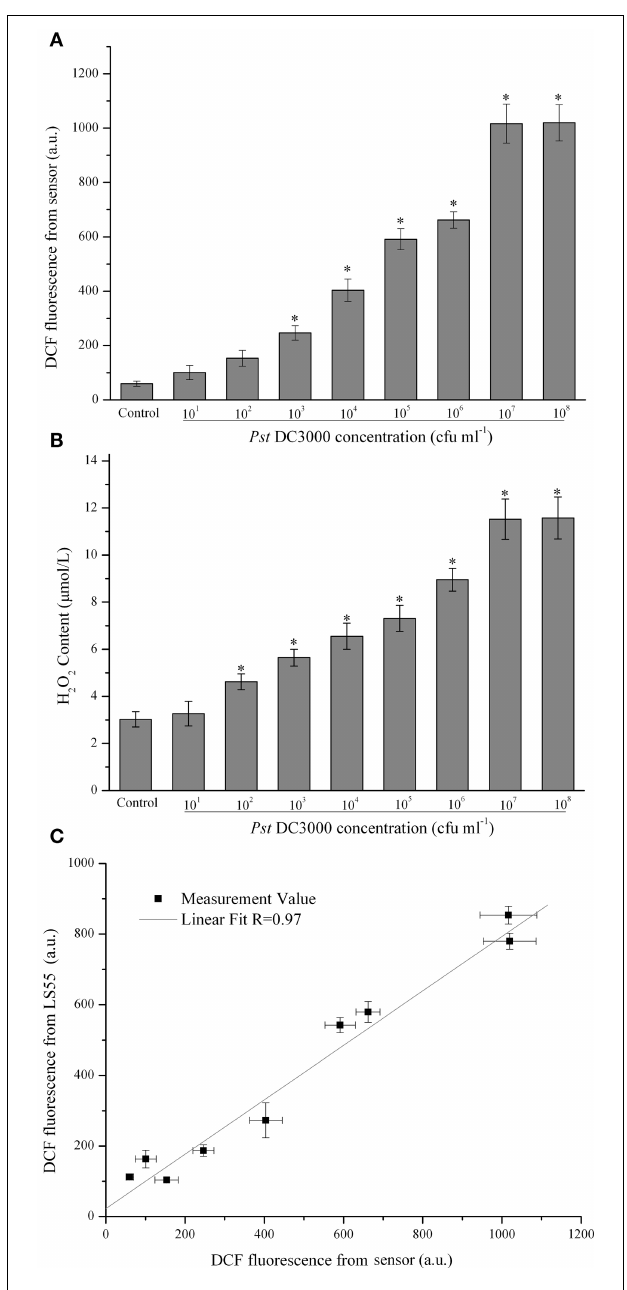
FIGURE 2 | Quantitative analysis of concentration-dependent changes in the dichlorofluorescein (DCF) fluorescence intensity of Arabidopsis thaliana (A. thaliana) leaves infected with Pseudomonas syringae pv .tomato DC3000( Pst DC3000). TheDCFfluorescencewasdeterminedby the optical device with difference concentration of Pst DC3000 infection (A) . The mean ± SD of the fluorescence intensity is shown for five independent A. thaliana leaves inoculated with Pst DC3000 or 10mM MgCl 2 (Control). There were a significant effect of DCF fluorescence obtained from optical device on the infected concentration with Pst DC3000 ( F 1 , 8 = 228 . 179, p < 0 . 01). The H 2 O 2 content was determined according to the standard procedureofahydrogenperoxideassaykit (B) .Therewereasignificanteffect of ROS content obtained from optical device on the infected concentration with Pst DC3000 ( F 1 , 8 = 97 . 519, p < 0 . 01). The asterisks indicate signif- icantdifferences( P < 0 . 01)comparedwiththeMgCl 2